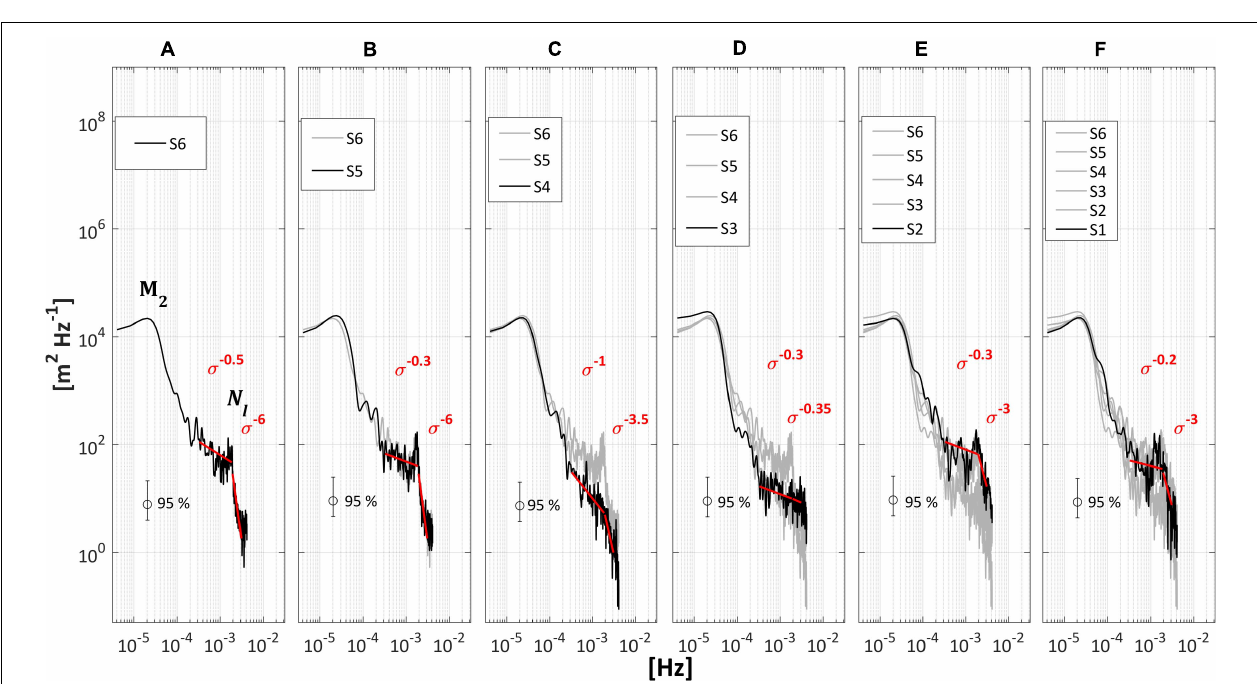
a minimum (0.3 m; Figure 4C , blue line), implying that just a weak pycnoclinic depression departed from the generation site and, consecutively as the depression moved onshore, a tidal bore of minimum amplitude was formed (Gerkema and